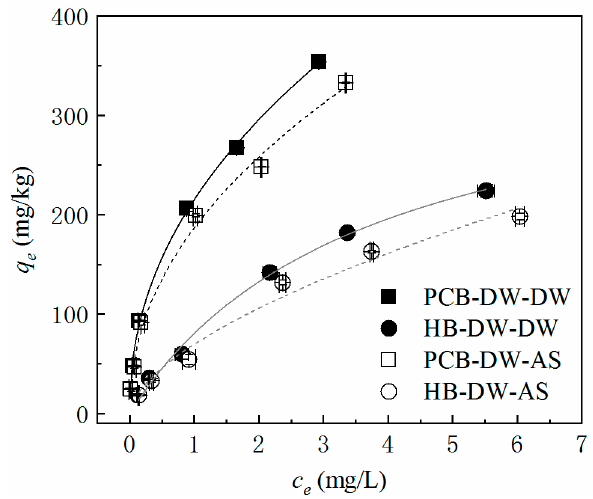
Figure 6. Adsorption isotherms of PCB-DW and HB-DW in DW or AS.